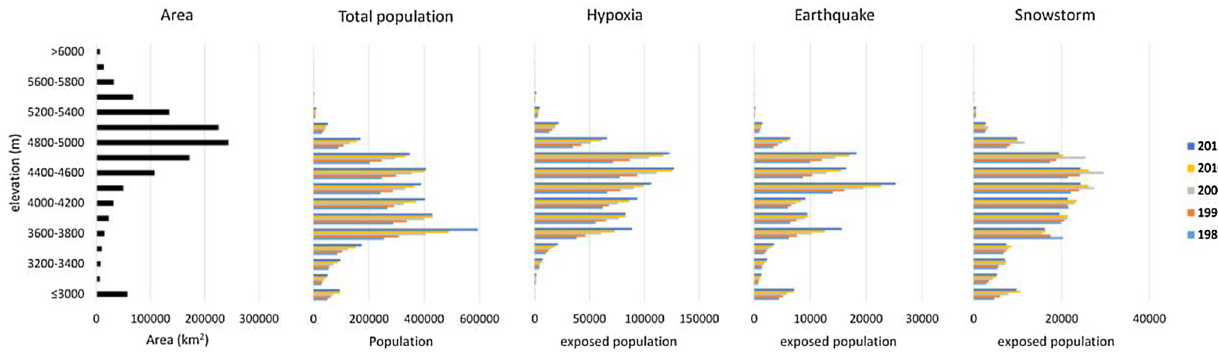
Fig. 3 Population exposure to each hazard by elevation range and time period in